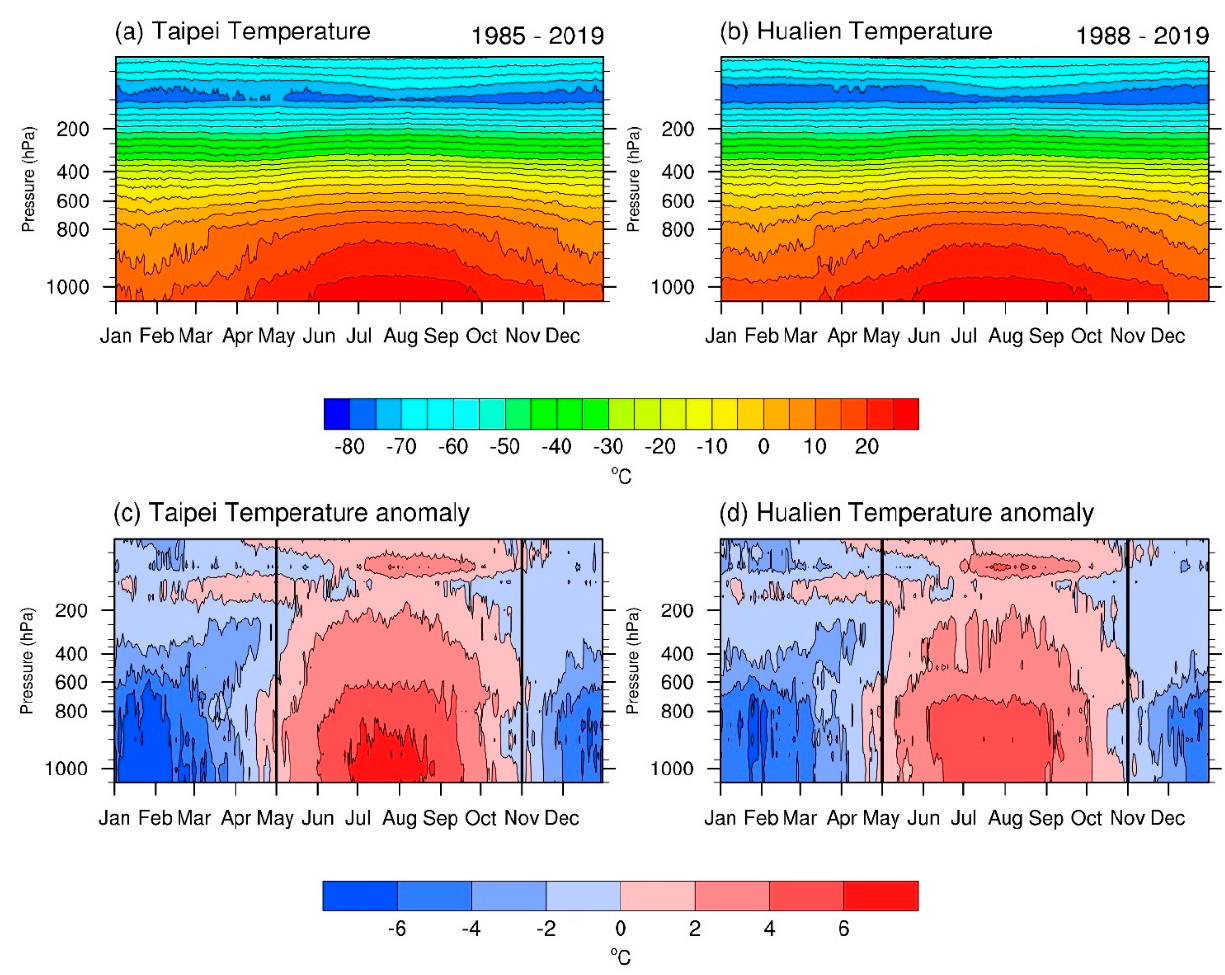
Figure 3. Climatological annual cycle of vertical temperature profile over the ( a ) Taipei sounding station and ( b ) Hualien sounding station, unit: °C. ( c , d ) are same as ( a , b ) but for the anomaly relative to the annual mean. The black lines on 1 May and 1 November denote the transitions of the winter half (from November through next April) and the summer half (from May through October).